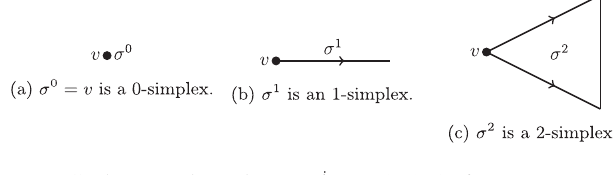
FIG. 5. Regular pair v ⊆ σ i ( i ¼ 0 , 1, 2) for vertex v .